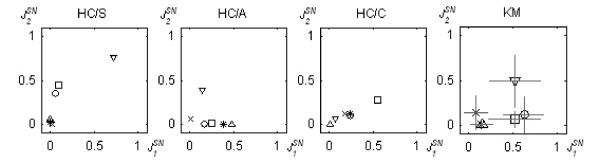
B: AML dataset: stability-normalized pairwise Jaccard indices of cluster labels assigned by the various methods. Clusterings into k = 12 clusters obtained using correlation distance on 3000 probe sets. Legend is shown in Figure 3D. For k-means, the grey bars indicate standard deviation over 10 repeated experiments.